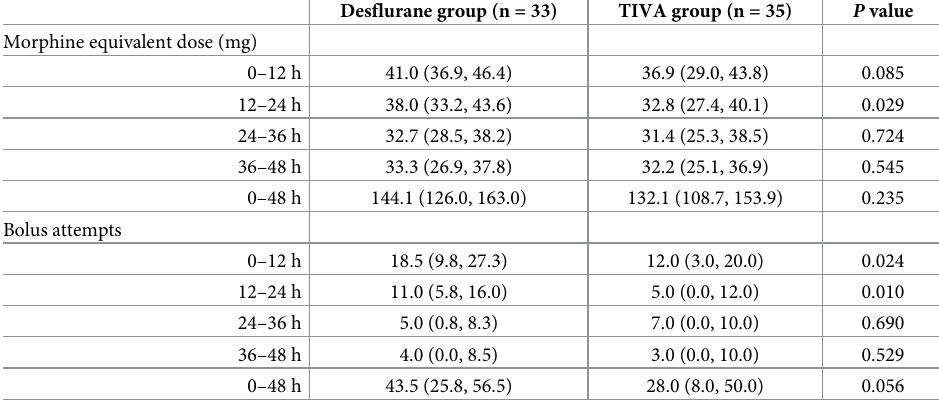
Table 4. Data on intravenous patient-controlled